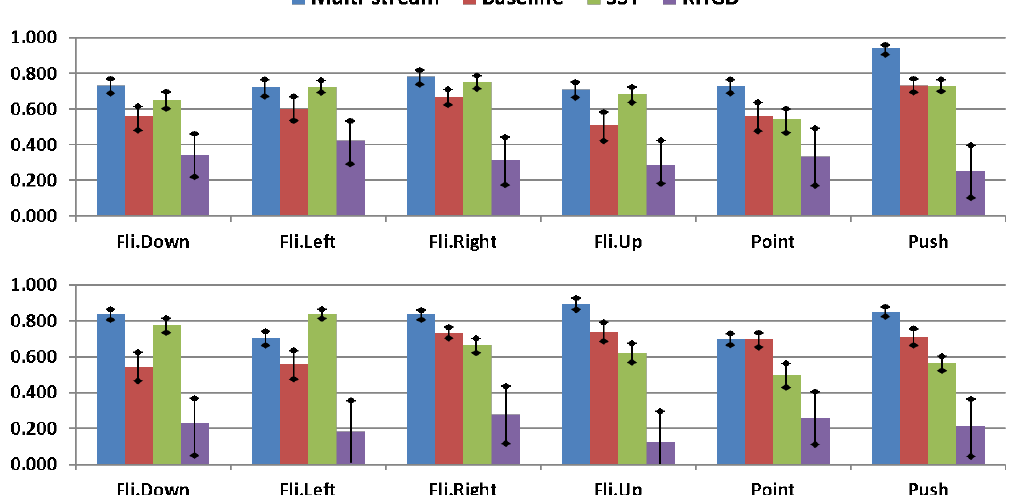
Figure 11. Comparision of AR results per class. ( top ) Validation results. ( bottom ) Testing results.